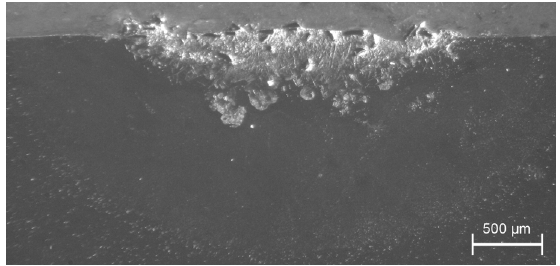
Figure 3. Laser dispersed SiC powder into Al6061 alloy: partially melted powder particles are accumulated in the top layer of the melted zone; processing parameters: E 0 = 217 J/mm 2 , ν sc = 7 mm/s, m p = 1.3 g/min.